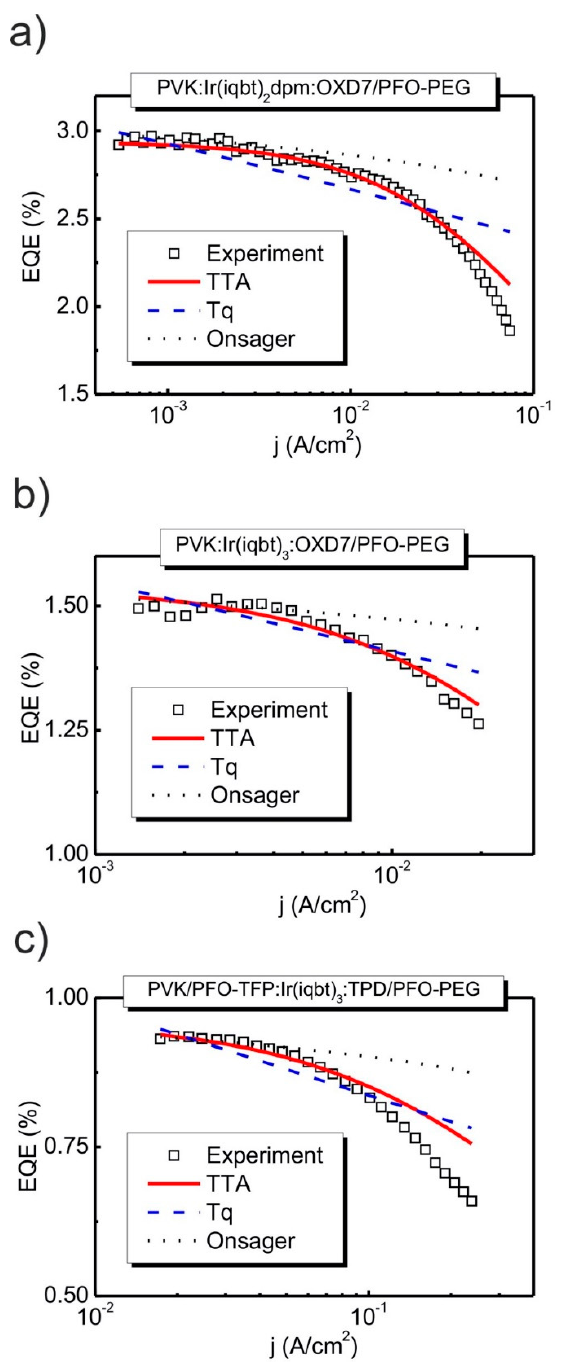
Figure 4. The EQE experimental data (squares) for ( a , b ) double-layer and ( c ) three-layer NIR OLEDs, as compared to the curves based on the TTA, Tq and the Onsager models of the roll-off effect (lines). The calculations for the Onsager approach were performed assuming r 0 /r c = 0.1, i.e., r 0 = 1.9 nm for T = 298 K and ε (cid:2928) = 3 .